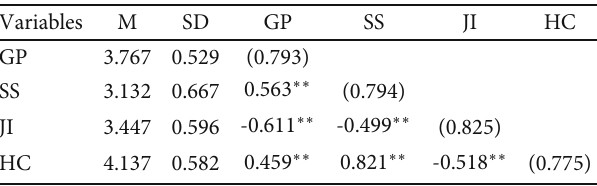
Table 2: Descriptive statistics and Pearson ’ s correlation.